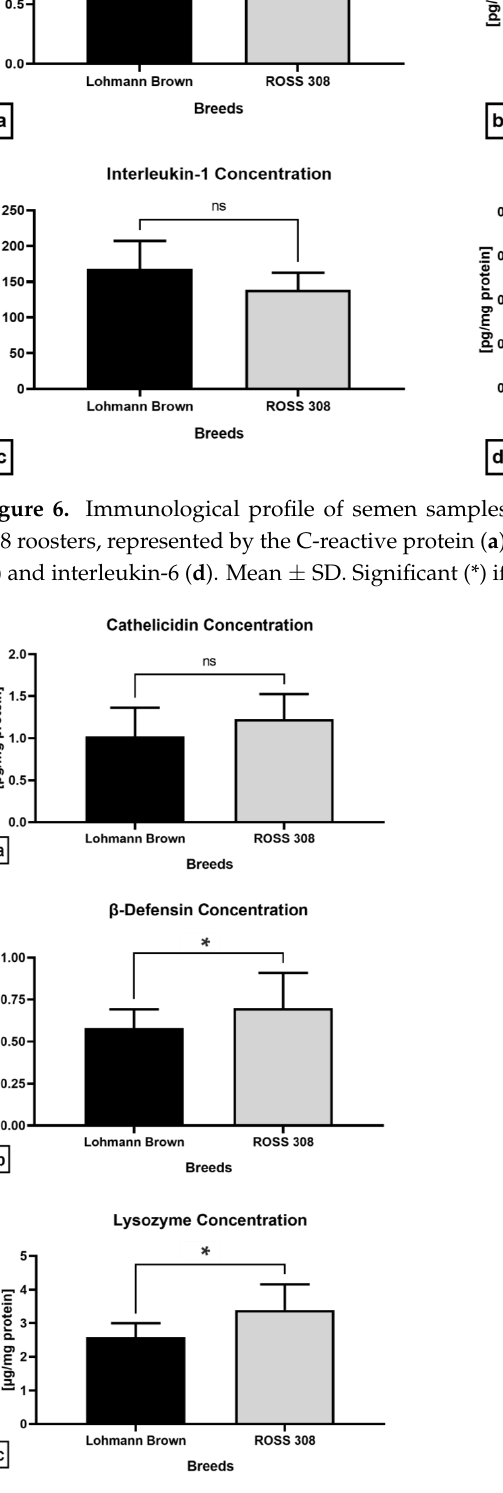
Figure 7. Levels of cathelicidin ( a ), β -defensin ( b ) and lysozyme ( c ) in ejaculates collected from Lohmann Brown and ROSS 308 roosters. Mean ± SD. Significant (*) if p < 0.05. ns — non-significant.